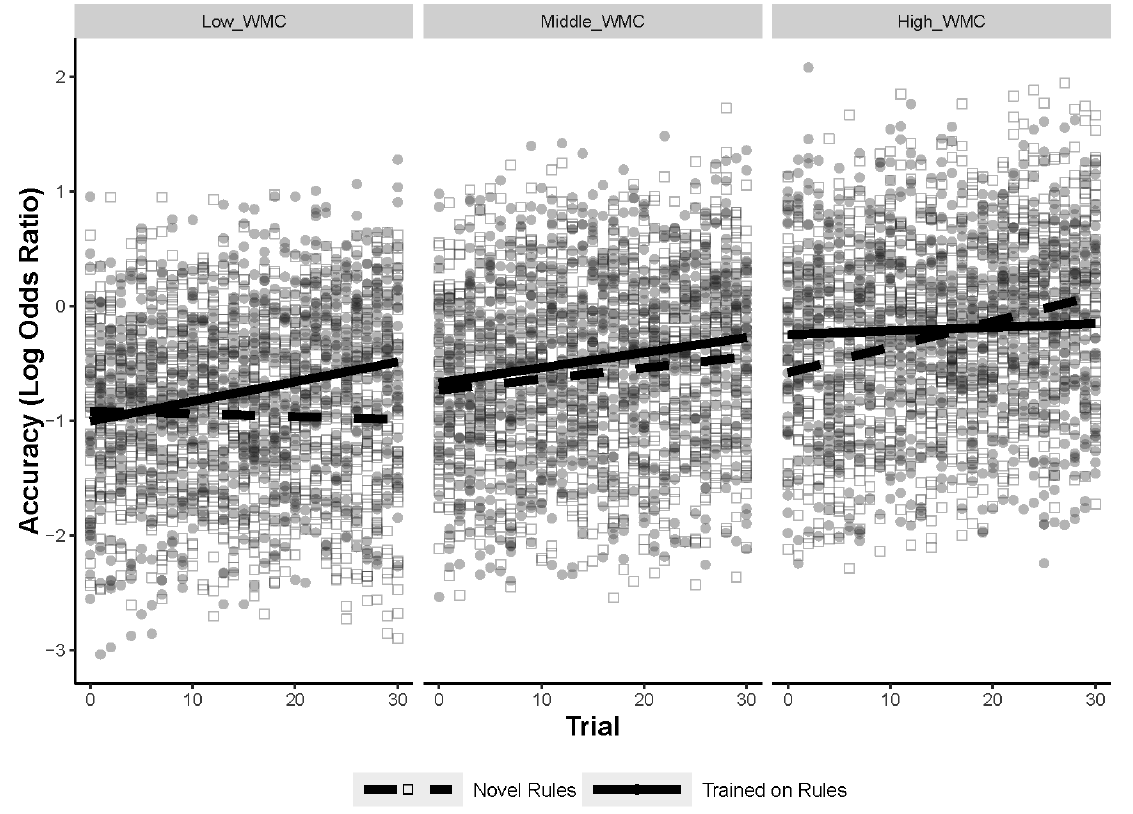
Figure 7. Interaction between WMC, training, and trial. Note. The plot was generated using the predict function in R to generate log odds ratio accuracy data based upon the model in Table 4. The data points represent item-level data for all participants and the linear slopes were generated with the geom_smooth function in ggplot. The model was analyzed with WMC as a continuous predictor but a tertiary split was used to plot the data. The circles represent trained-rule items and the squares represent novel-rule items.